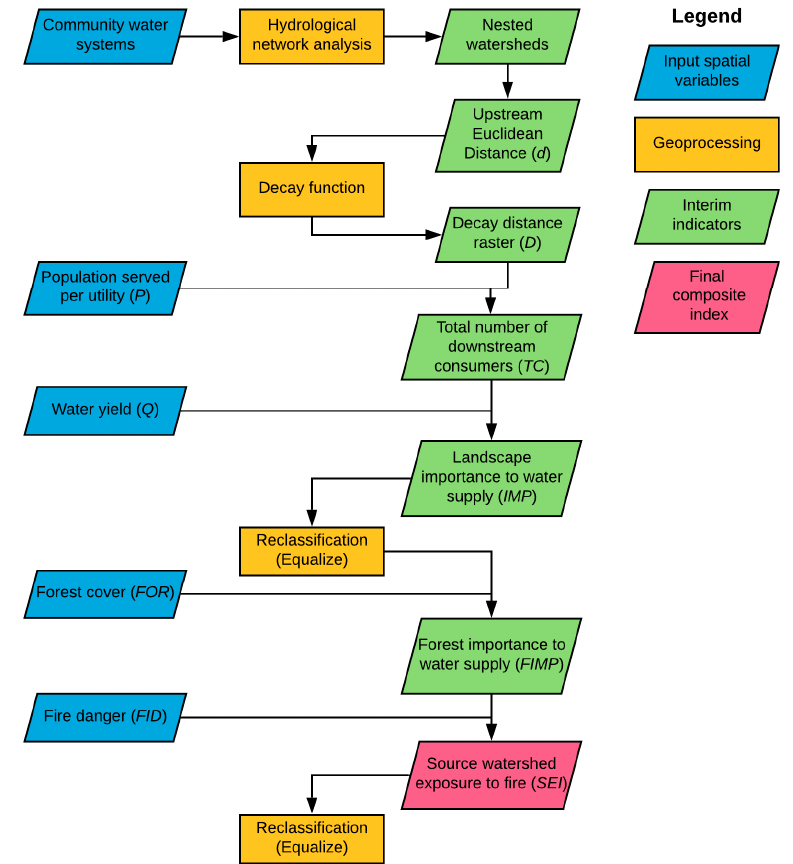
Figure 3. Flowchart describing the incremental steps for the creation of the Source Exposure Index ( SEI ), representing inputs, geoprocessing, and outputs. Adapted from Weidner and Todd (2011). Note that interim indicators are created following an incremental design that builds on the output of the previous step and updates it with the values of a new input. Blue parallelograms represent additional inputs, rectangles represent processes, green parallelograms represent interim indicators, and pink parallelogram represents the final composite index.